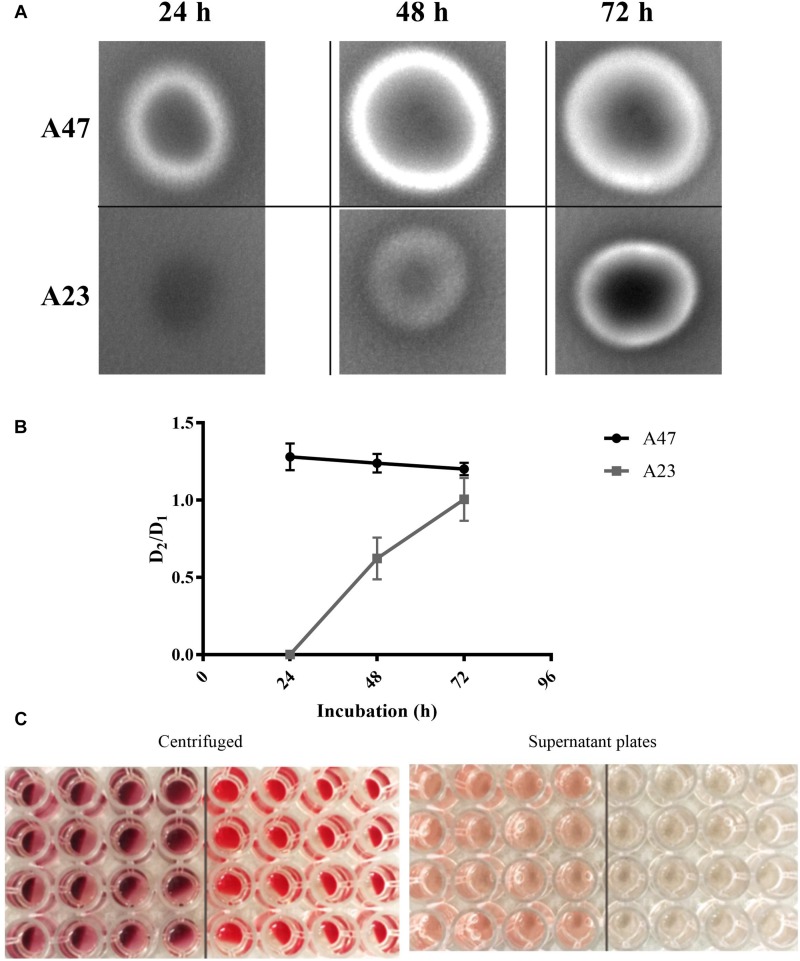
(A) Observed hemolytic activity in A47 and A23. TSA supplemented with 5% rabbits’s blood was inoculated with A47 and A. haemolyticus A23, incubated at 37°C and imaged at 24, 48, and 72 h post-inoculation. A47 and A23 exhibit β-hemolysis generating a zone of clearing around colonies, representative of complete lysis of red blood cells. (B) Quantification A47 and A23 hemolysis. Blood agar plates were aseptically inoculated with colonies of A47 and A23, and incubated at 37°C. The diameters of lytic zones (D2) and colonies (D1) was measured at 24, 48, and 72 h. Hemolysis is reported as the average ratio (D2/D1), data points represent individual ratios for each biological samples (n = 16). The curve intersects at the average D2/D1 for each time point. (C) A47 exhibits visible signs of hemolytic activity. Compared to LB conditions on right half, A47 wells exhibit visible signs of hemolytic activity, evidenced in both centrifuged (C1) and supernatant plates (C2). The deep red color change indicates hemolytic activity in (C1), and the effect of lysed blood cells bleeding out into the supernatant is shown in (C2).